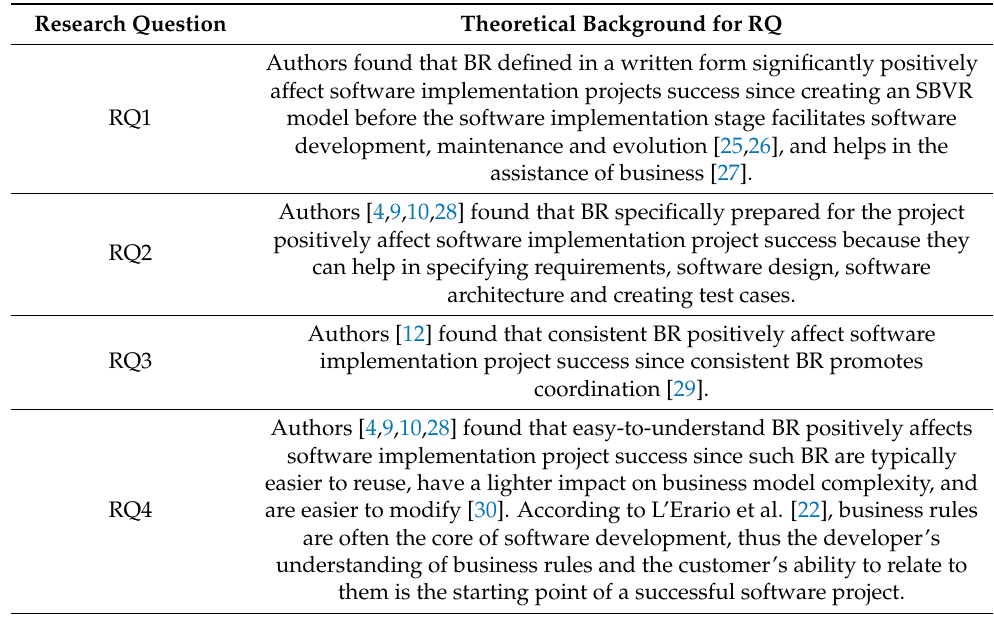
Table 1. Research questions and their theoretical